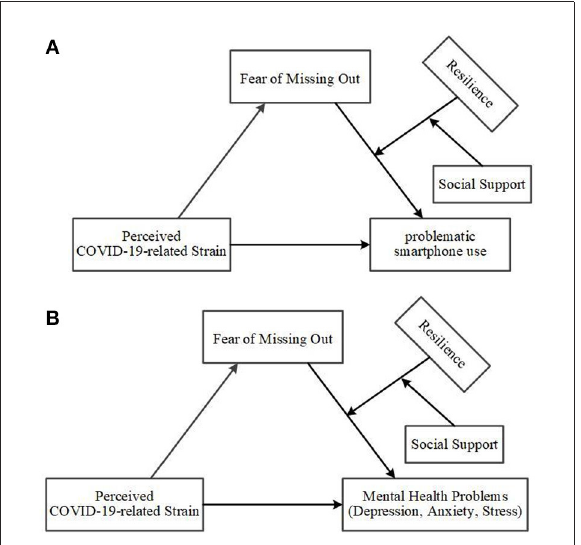
FIGURE1 (A) The moderated moderated-mediation model of problematic smartphone use. (B) The moderated moderated-mediation model of mental health